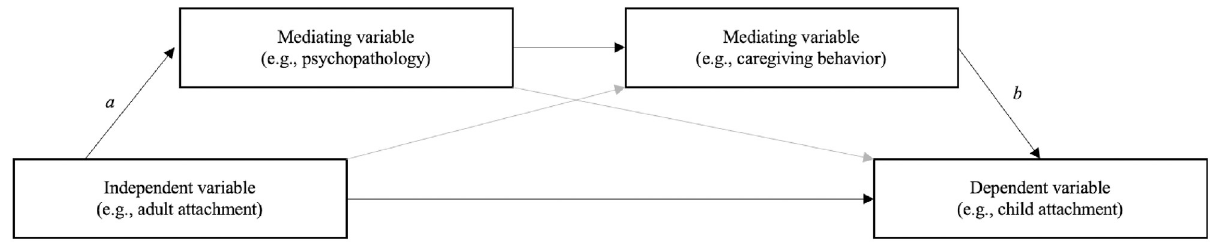
Fig 1. Serial mediation